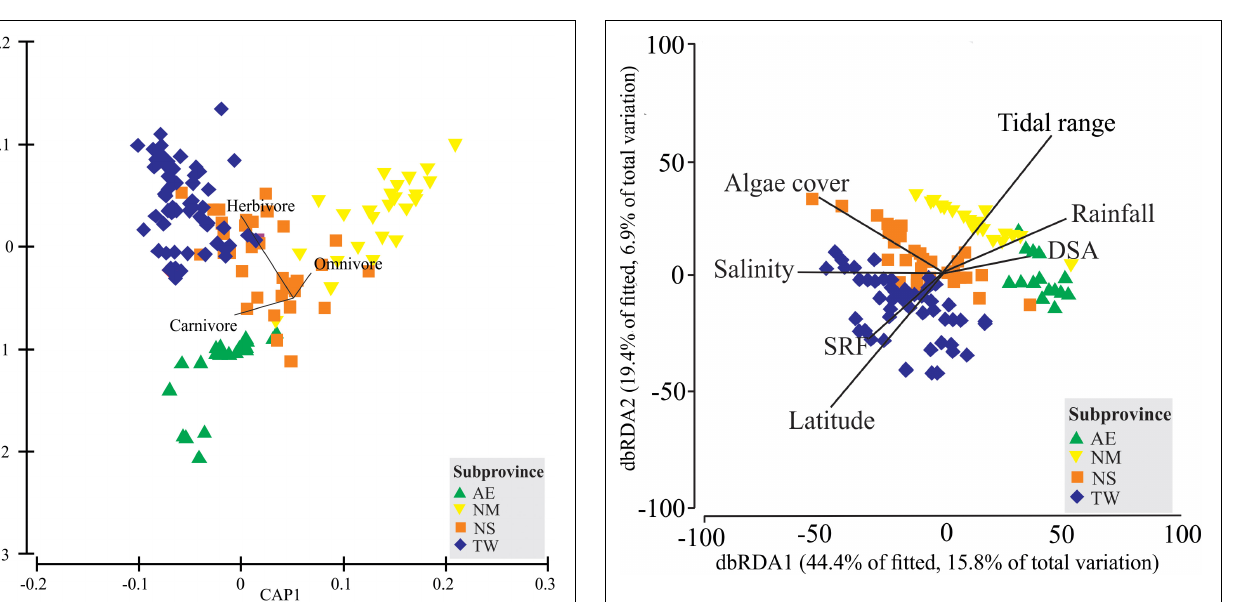
FIGURE 5 | Biplot of the results of the redundancy analysis of the biological and environmental data from 149 tidepools sampled at 19 sites in the four Brazilian coastal subprovinces. Samples with no fish data ( N = 3) were omitted from this analysis. SRF, Shape of Rocky shore Formation; DSA, Distance to Subtidal Area. Subprovinces: AE, Amazon estuary; NM, Northern mangrove; NS, Northeastern semiarid; TW, Tropical warm.